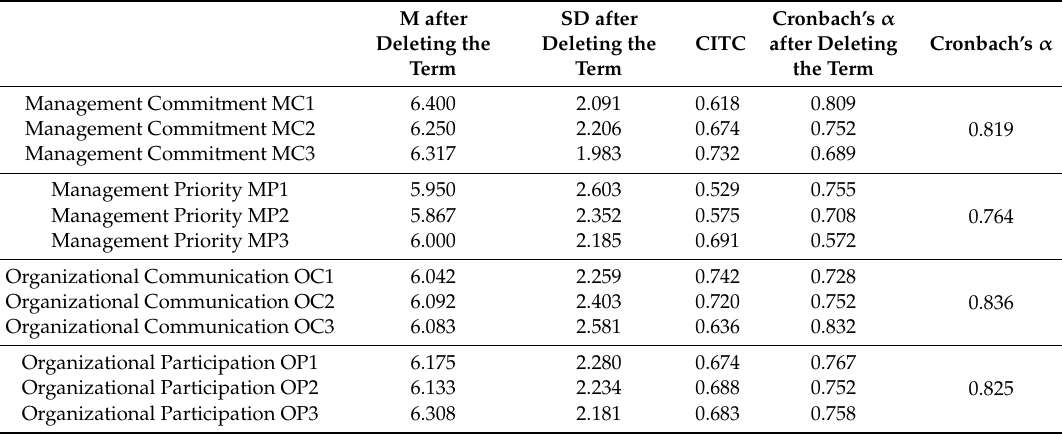
Table 5. PSC-12 reliability analysis.